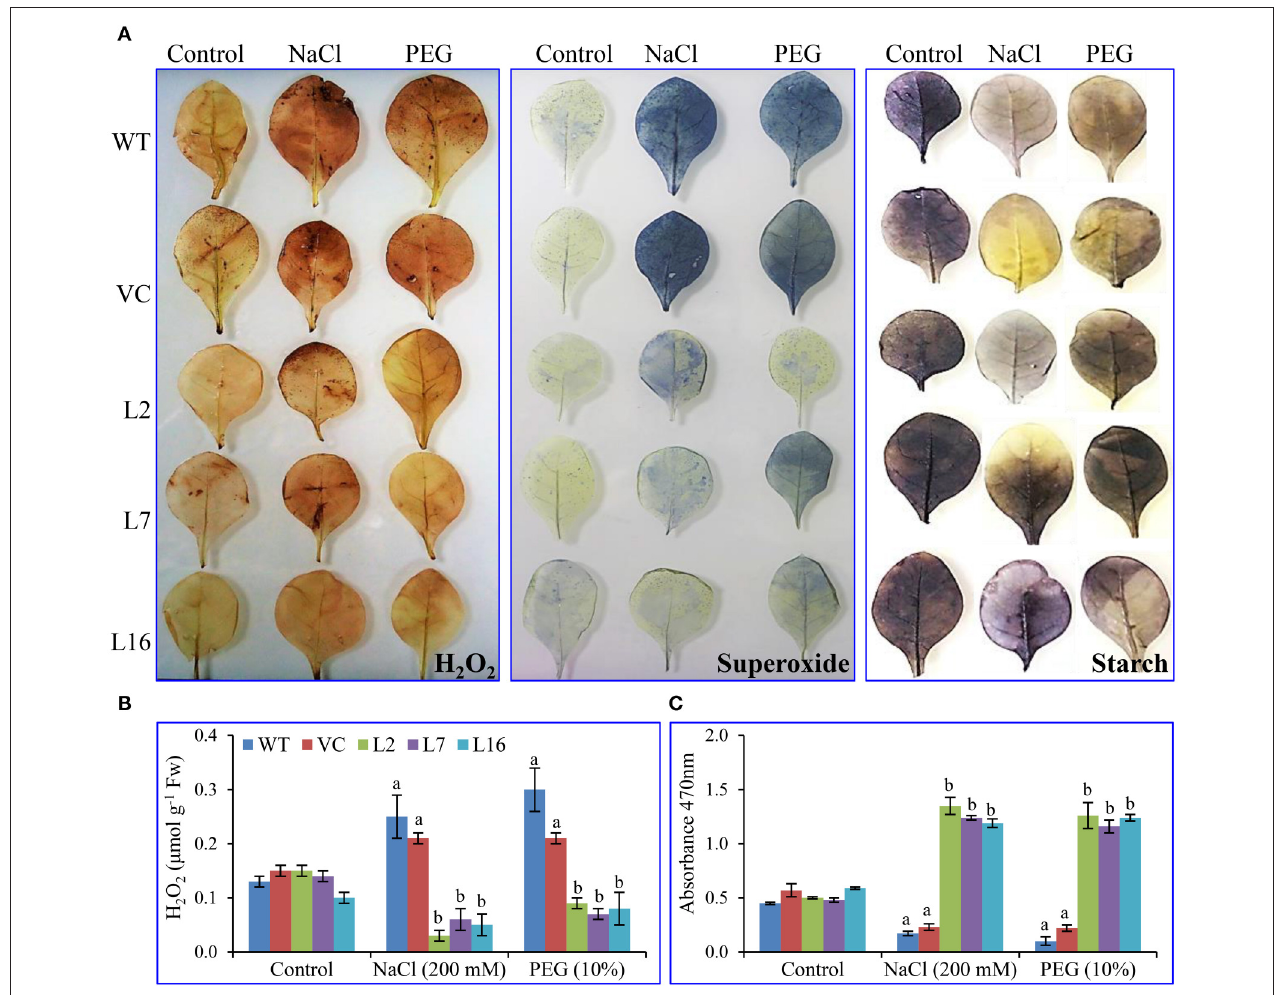
FIGURE 6 | In vivo localization and cell viability. (A) In vivo localization of H 2 O 2 , superoxide and starch, estimation of (B) H 2 O 2 content and (C) superoxide radicals of transgenic (L2, L7, and L16) and control (WT and VC) leaves. Bars represent means ± SE and values with different letters are significant at P <